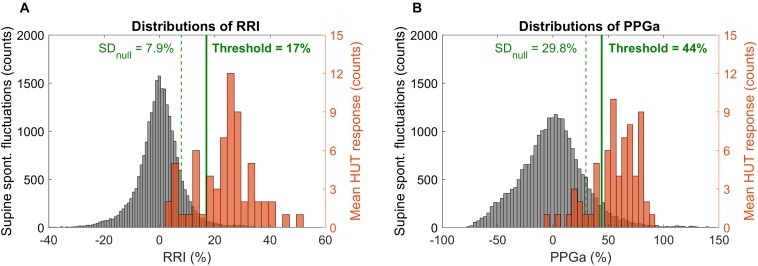
Distributions of spontaneous fluctuations during supine (null distributions, gray) and distributions of the mean change during HUT (orange) in RRI (A) and PPGa (B). Note that the distributions of spontaneous fluctuations consider all sample points during supine while the mean HUT response distributions constitute of one value of ΔRRI or ΔPPGa per subject. Dashed vertical lines indicate 1 standard deviation of the null distributions (level of spontaneous fluctuations during supine). Solid lines indicate the optimal thresholds in RRI and PPGa for HUT response classification.